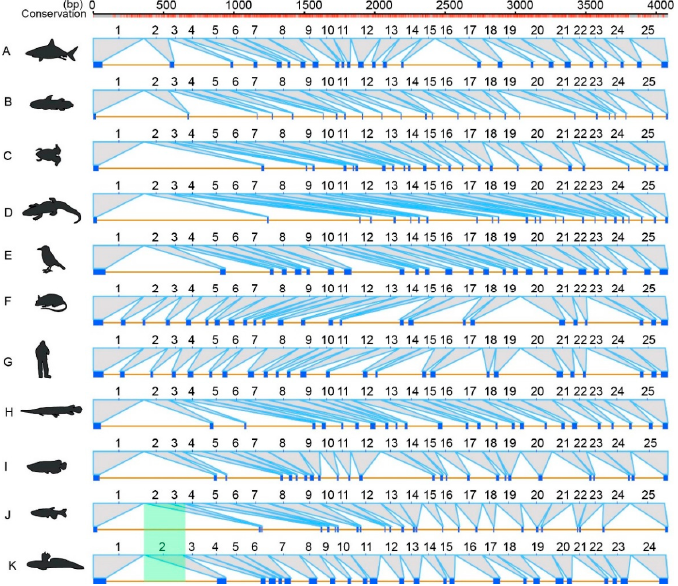
Figure 5. Sequence alignments of the ace gene structures in 11 representative vertebrates. Numbers in the top stand for the length of nucleotide base pairs (bp). Red bars in the top indicate the conservation status of the ace alignments. The green color shaded region indicates the species-special variations. The representatives include elephant shark ( A ), coelacanth ( B ), tropical clawed frog ( C ), American alligator ( D ), Tibetan ground-tit ( E ), house mouse ( F ), human ( G ), spotted gar ( H ), Asian arowana ( I ), zebrafish ( J ) and the representative mudskipper Bp ( K